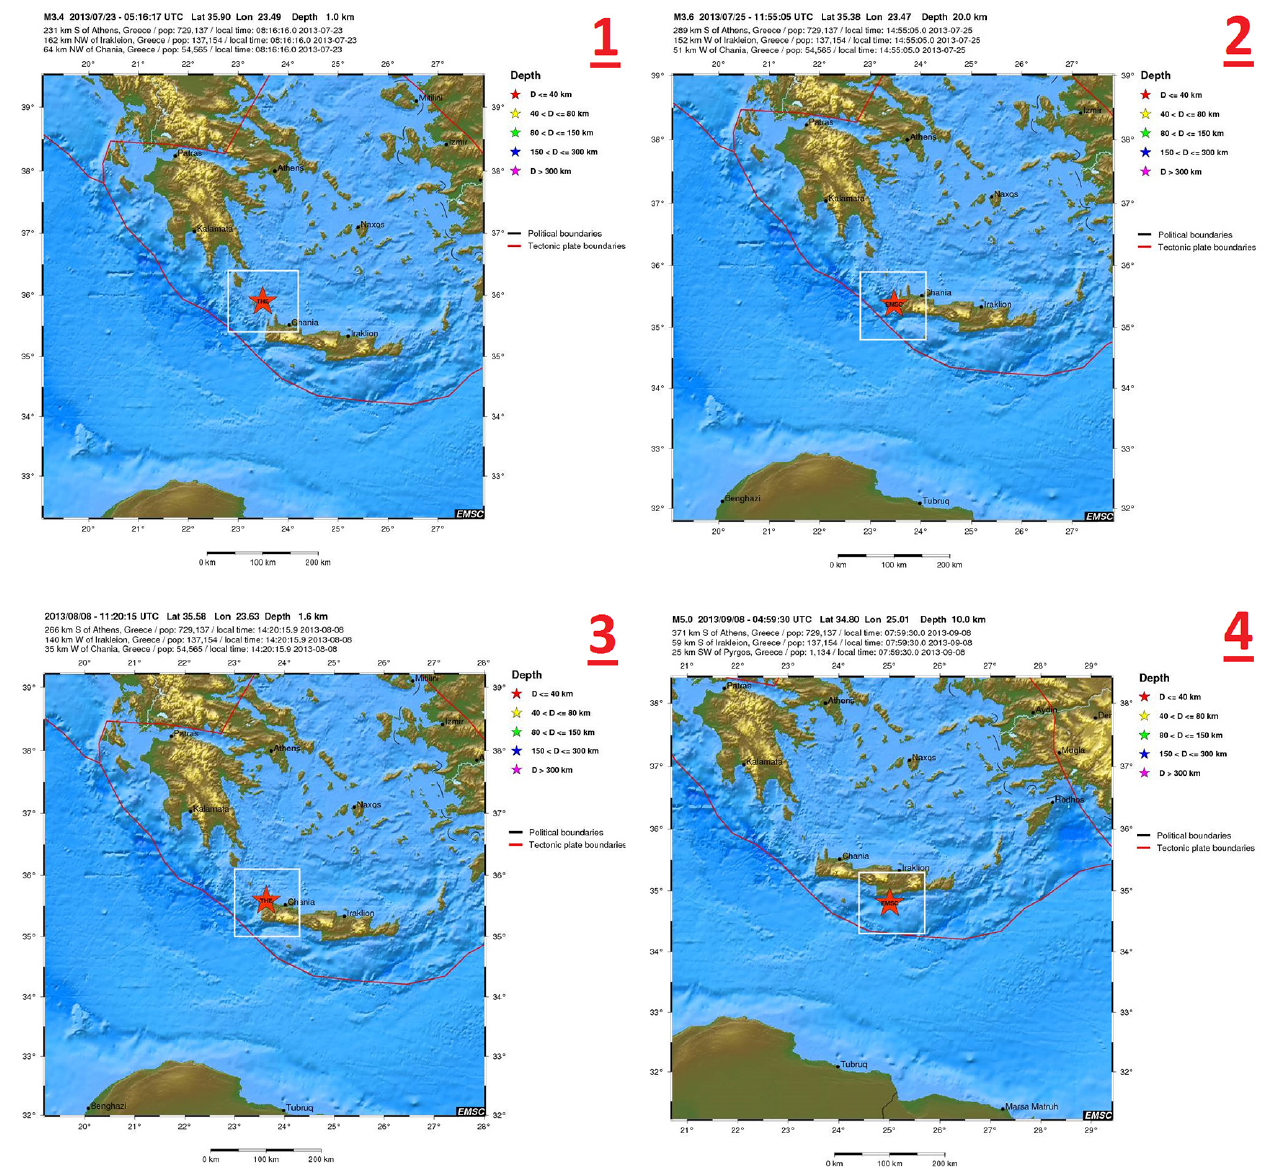
Figure 12. Four seismic events with code names 1 (top left), 2 (top right), 3 (bottom left) and 4 (bottom right) by EMSC (http://www.